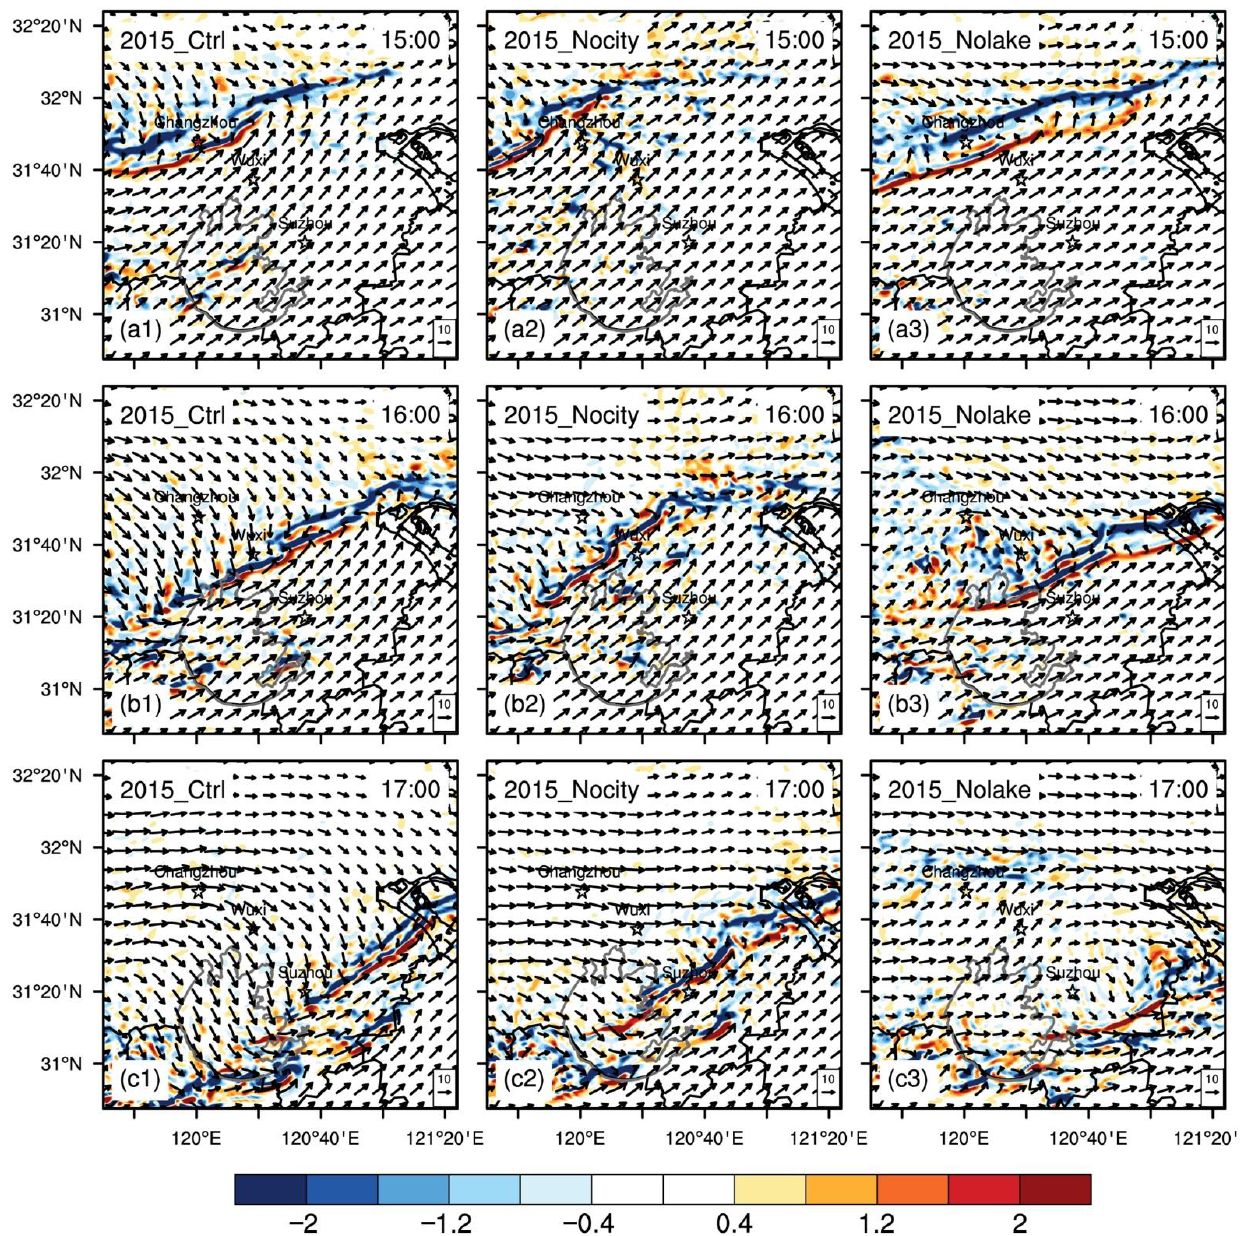
Figure 11. The spatial distributions of the 850 hPa wind direction and divergence (unit: 10 −3 s −1 ) for the ( a1 , b1 , c1 ) control, ( a2 , b2 , c2 ) Nocity, ( a3 , b3 , c3 ) Nolake runs for EP627. The moving direction of the 850 hPa shear line in Nocity is consistent with the control run (Figure11 a2,b2,c2). The intensity and position at 15:00 are similar to those of the con- trol run, but the moving speed is significantly slower for the next two times and the loca- tion is more northwest. However, the intensity changes little and does not intensify and weaken as markedly as in the control run. The corresponding SCL shows an intensifying trend (Figure 8a2,b2,c2), and the position is similar to the 850 hPa shear line, but its inten- sity is clearly weaker than in the control run. The moving direction of the 850 hPa shear